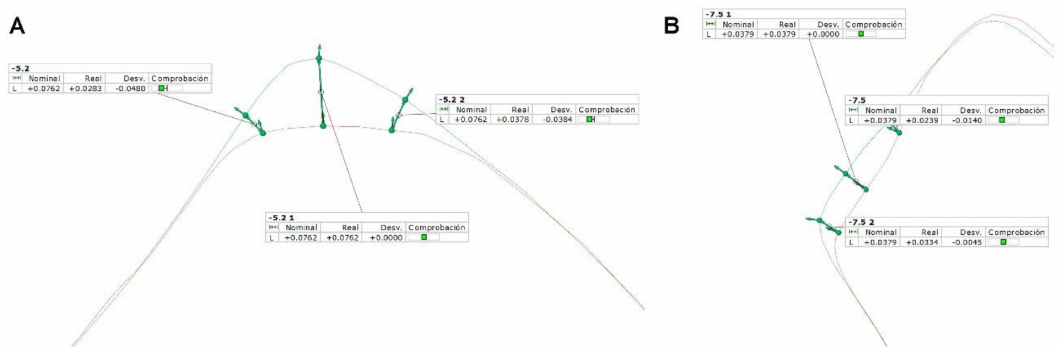
Figure 4. ( A ) Alignment of the STL 1 (green) and STL 2 (red) digital files to analyze the wear at the cutting edge and ( B ) radial lands.